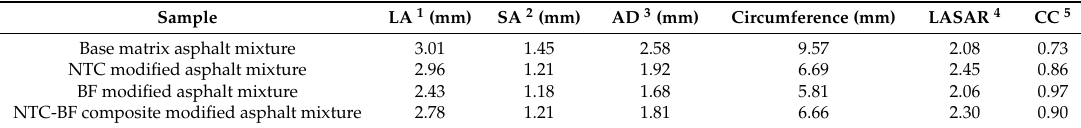
Table 5. Morphological characteristics of asphalt